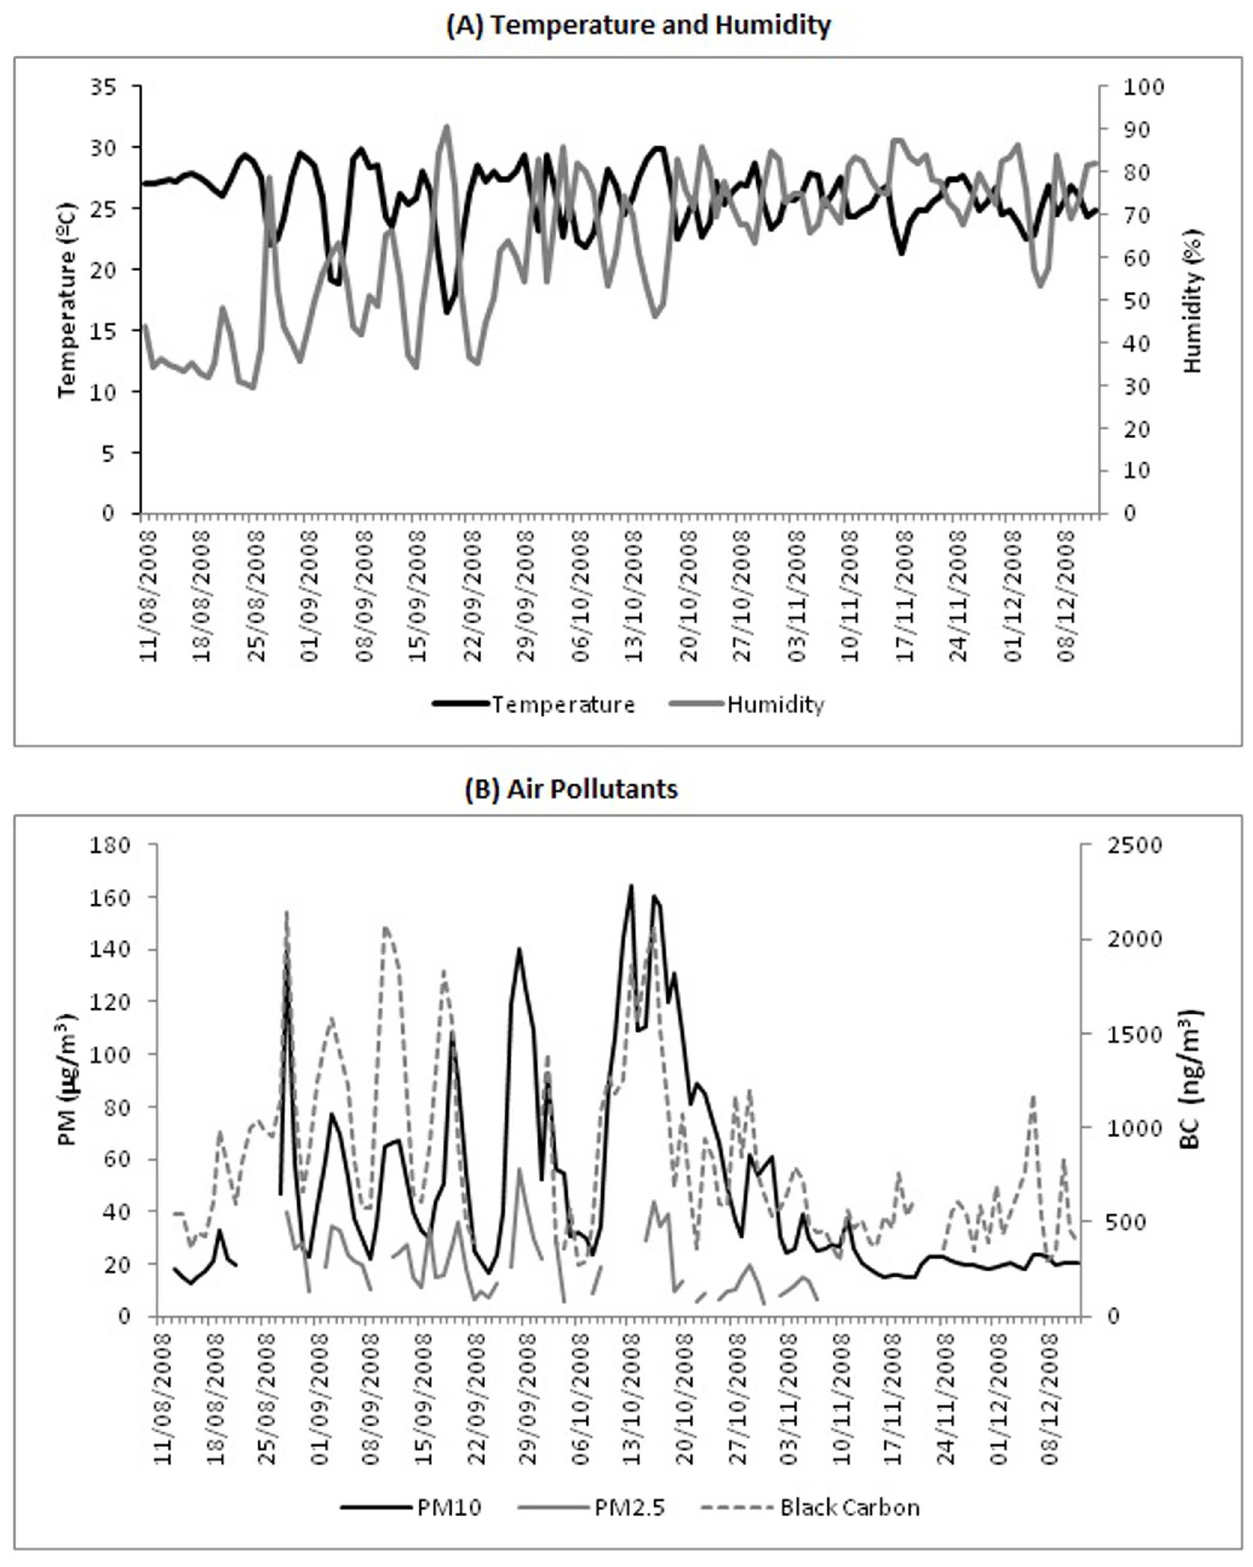
Figure 2. Daily temperature, humidity and air pollutant readings. Tangara´ da Serra, MT, Brazil-2008.